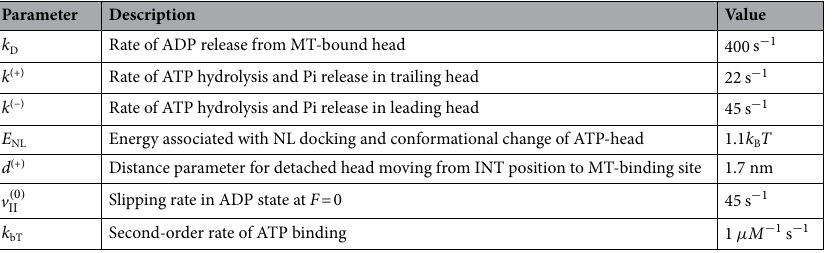
Table 1. Parameter values for Kip3 used in the